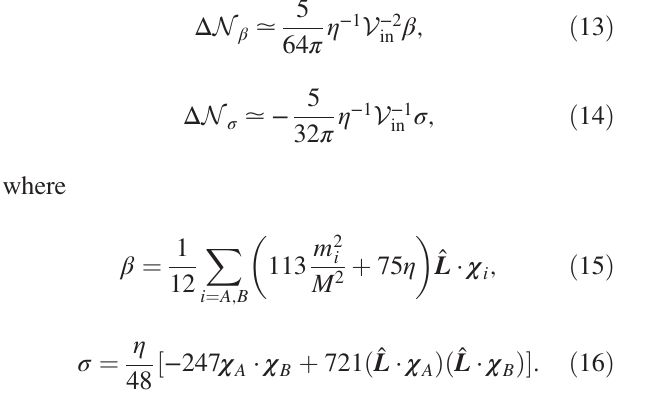
TABLE III. The number of GW cycles in GR, N its change due to the dipole radiation in the DEF ’ s theory, Δ N maximally allowed effective scalar couplings for the EOS SLy4 at 90% C.L. (see Fig. 5). The limits on the contributions from leading- order spin-orbit and spin-spin terms, j Δ N β j and j Δ N σ j , are listed where the (dimensionless) spins of the double pulsar (when it merges in 86 Myr) are used. For j Δ N β j and j Δ N σ j , we also show parenthetically the case where both NSs are spinning at the maximal spin that we have ever observed (in an eclipsing binary pulsar J 1748 − 2446